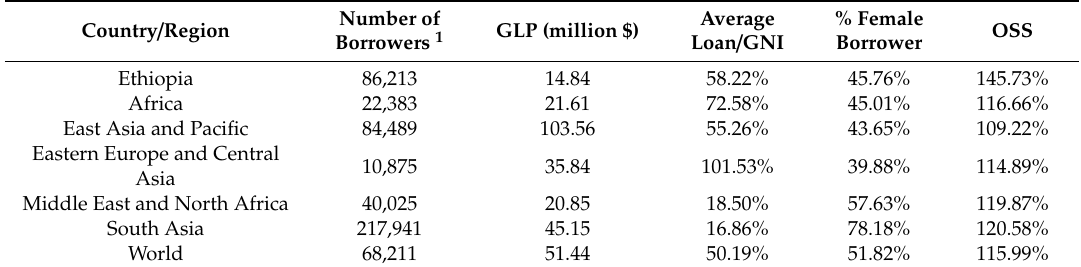
Table 2. Performance of microfinance institutions (MFIs) in Ethiopia: comparison with regional performance